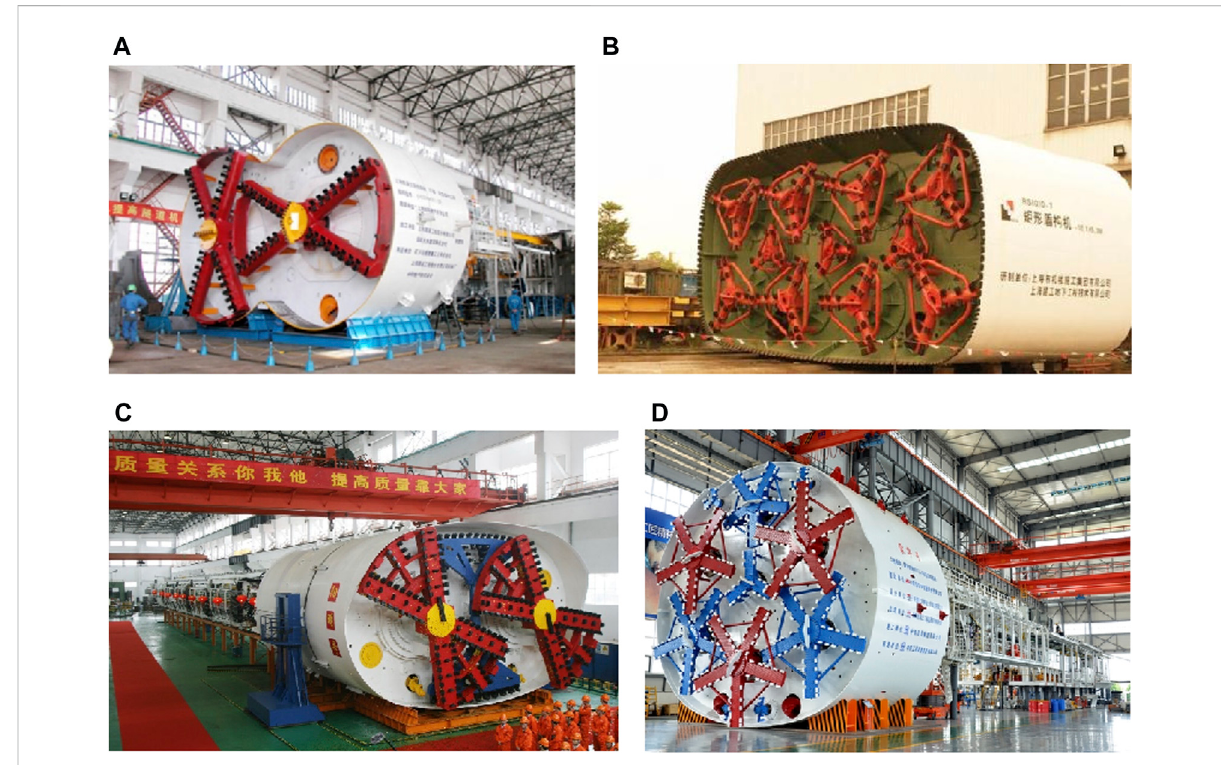
FIGURE 1 Several representative special-section shield machines: (A) DOT shield machine; (B) rectangular shield machine; (C) quasi-rectangular shield machine; (D) horseshoe-shaped shield